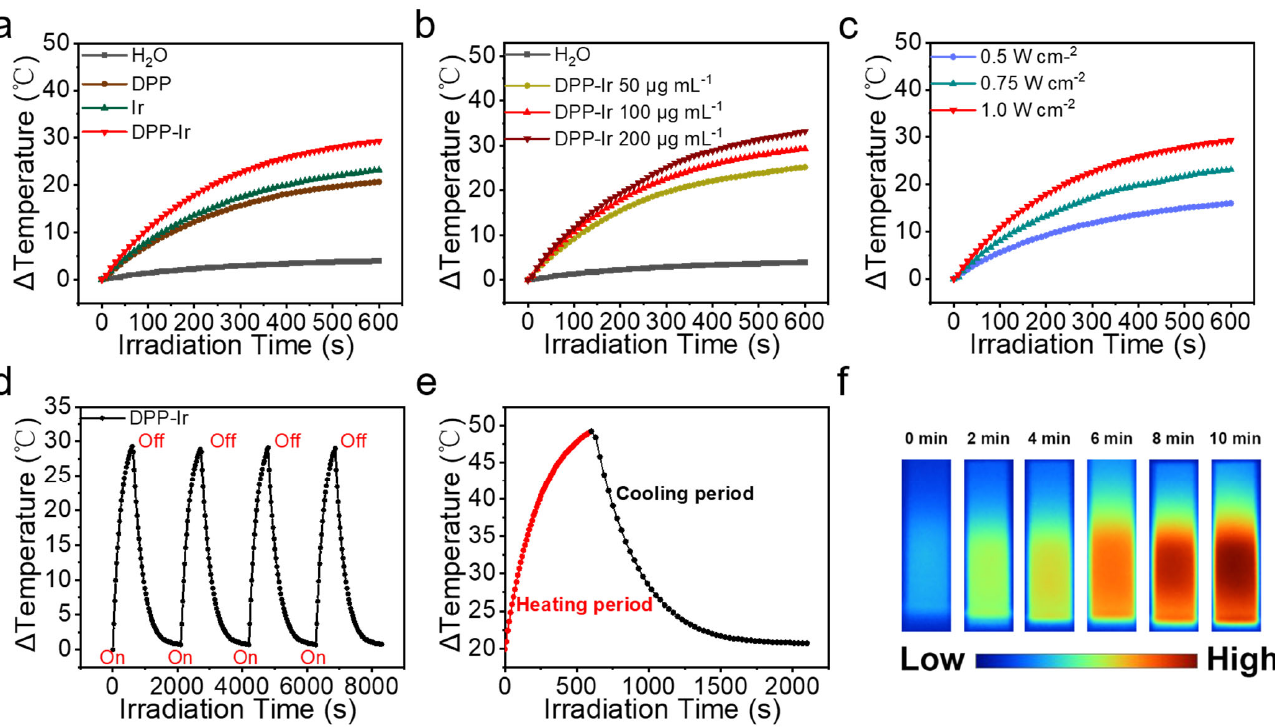
Figure 2. ( a ) Temperature elevation in three nanoparticles in equivalent concentrations (808 nm, 1.0 W cm − 2 ). ( b ) Temperature elevation in DPP ‐ Ir nanoparticles at different concentrations (808 nm, 1.0 W cm − 2 ). ( c ) Temperature elevation in DPP ‐ Ir nanoparticles under different power densities (100 μ g mL − 1 , 808 nm). ( d ) Temperature change in DPP ‐ Ir nanoparticles over four heating/cooling cycles (1.0 W cm − 2 ). ( e ) Photothermal response of DPP ‐ Ir nanoparticles in aqueous solution irradiated with 808